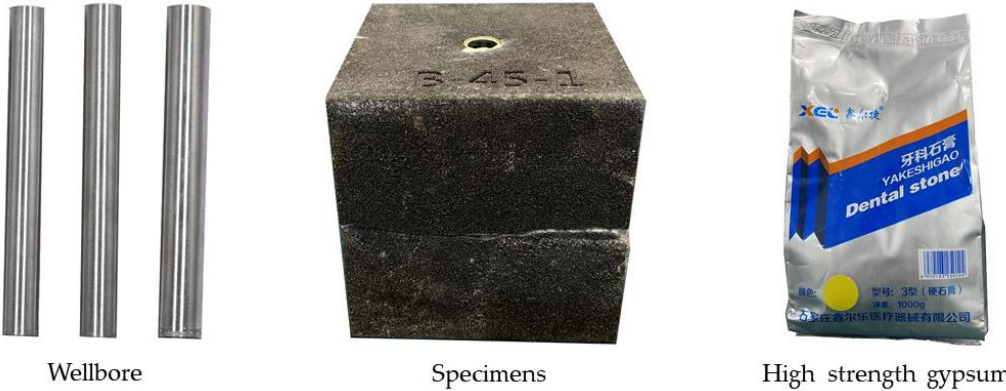
Figure 6. Experimental materials.